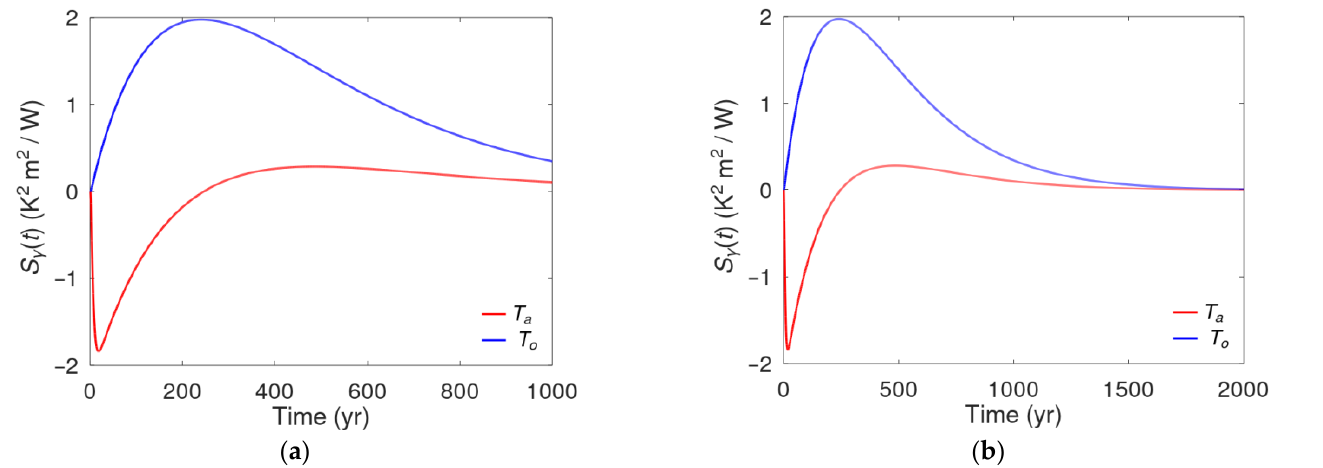
Figure 3. Sensitivities of global mean surface temperature (red line) and global mean deep ocean temperature (blue line) anomalies with respect to parameter 𝐶 (cid:3042) , calculated for step-forcing: ( a ) over time interval of 0–1000 years, ( b ) over time interval of 0–2000 years.